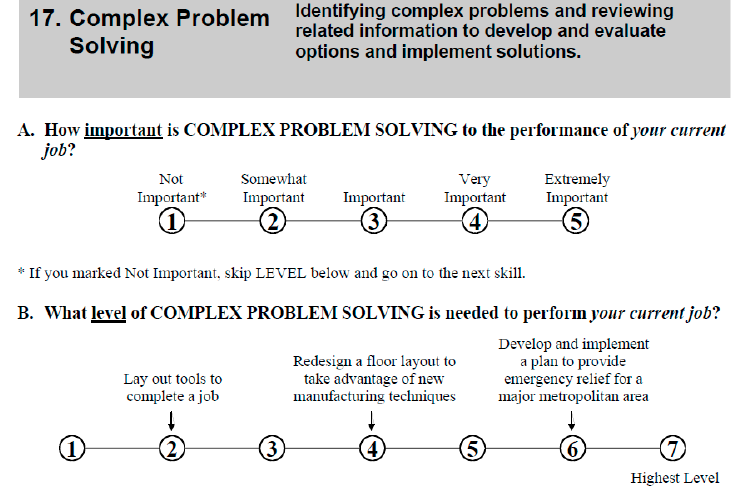
Figure 3. Complex Problem Solving item from the O*NET Skills Questionnaire.